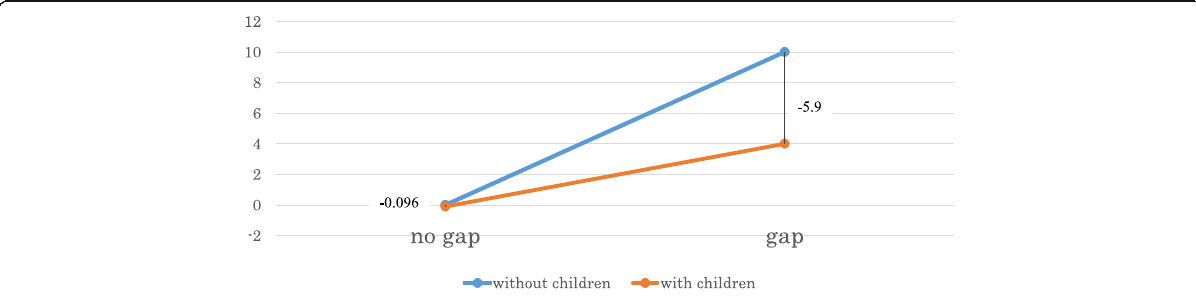
Fig. 1 An effect of WLB gap on burnout (with or without